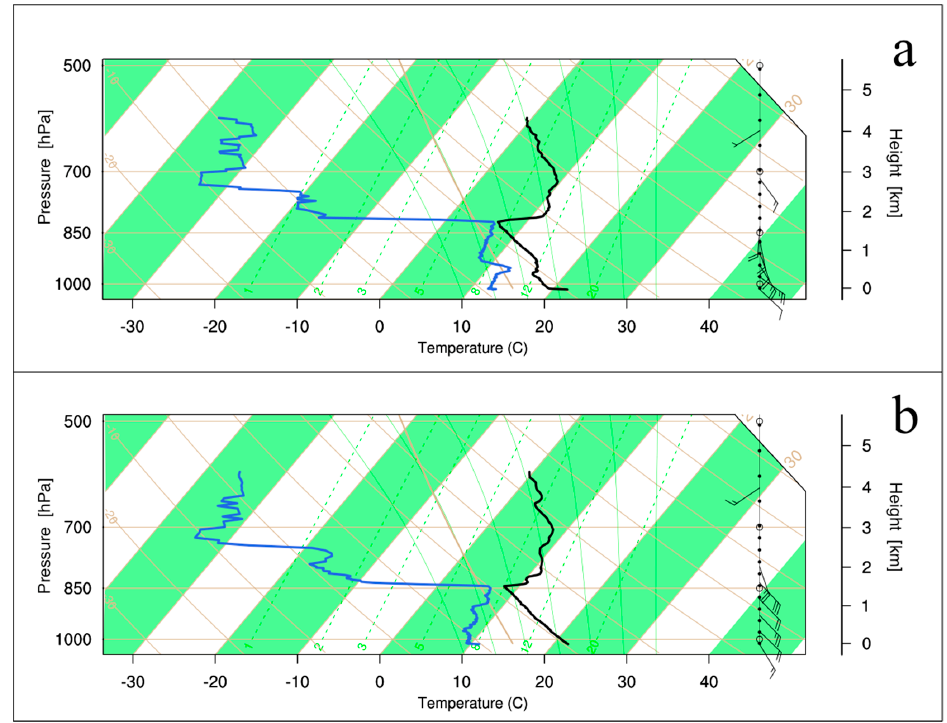
Figure 5. Skew-T diagram from radiosonde launches at Eglin Air Force base ( a ) prior to the L2F burn at 1525 UTC and ( b ) after the burn at 2149 UTC. The black line is air temperature (°C) while the blue line represents the dew point temperature (°C).